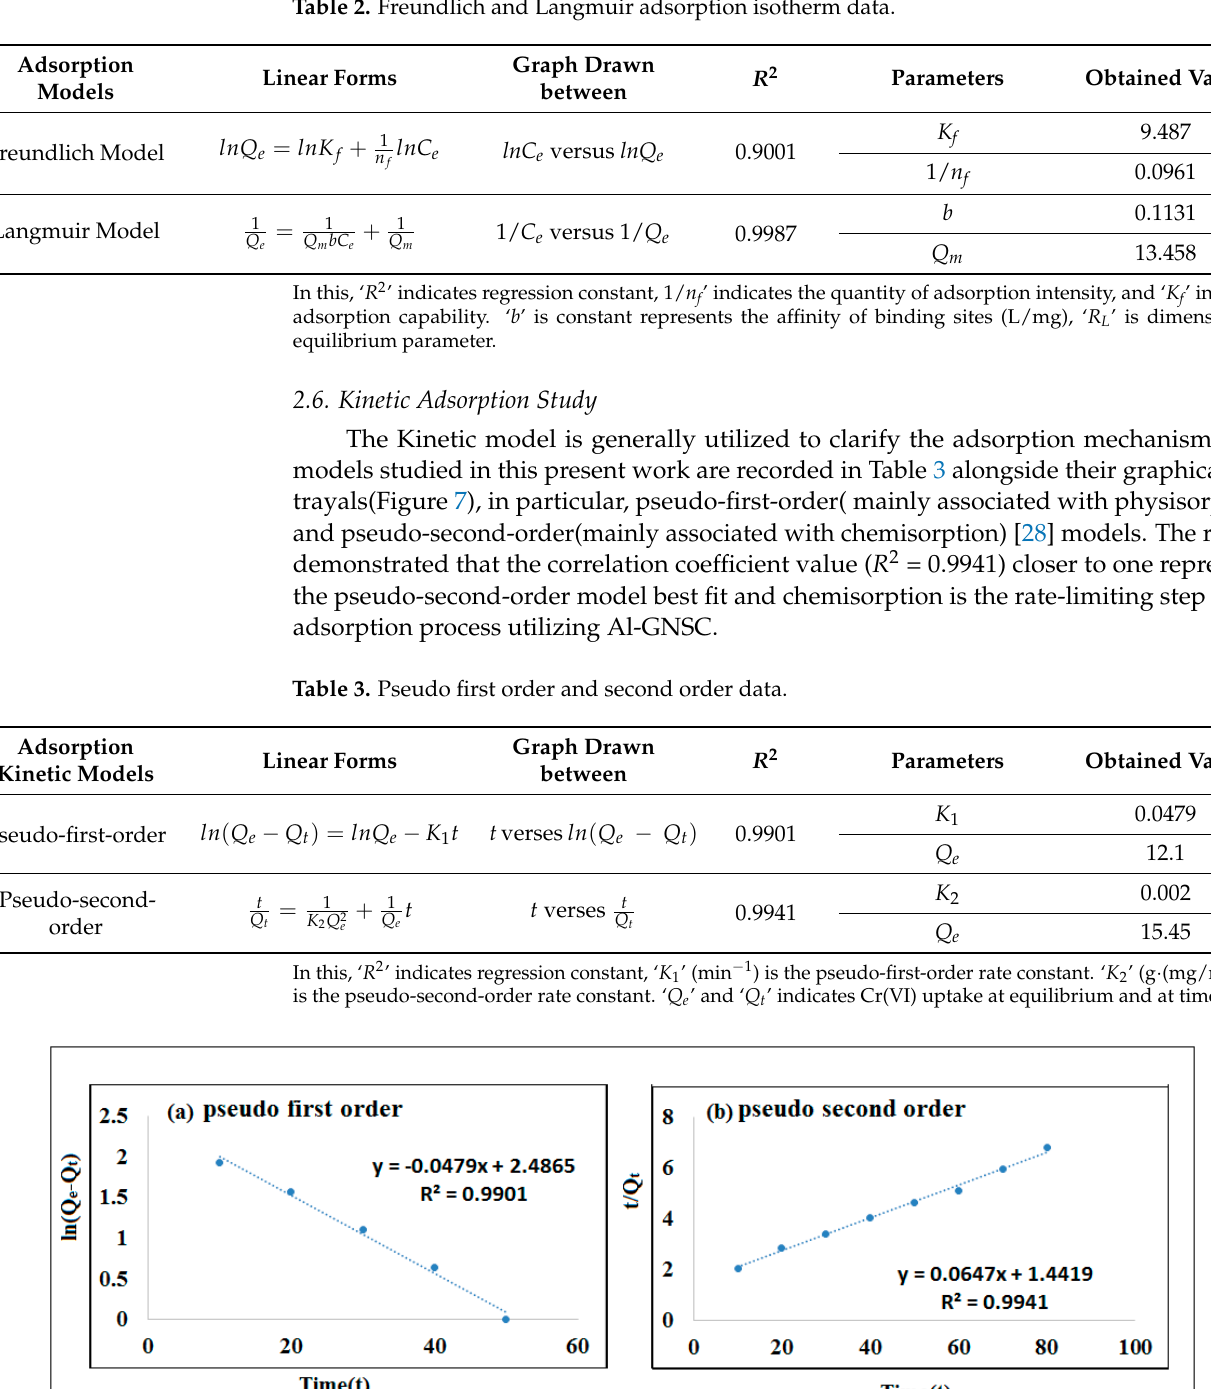
Table 2. Freundlich and Langmuir adsorption isotherm data.